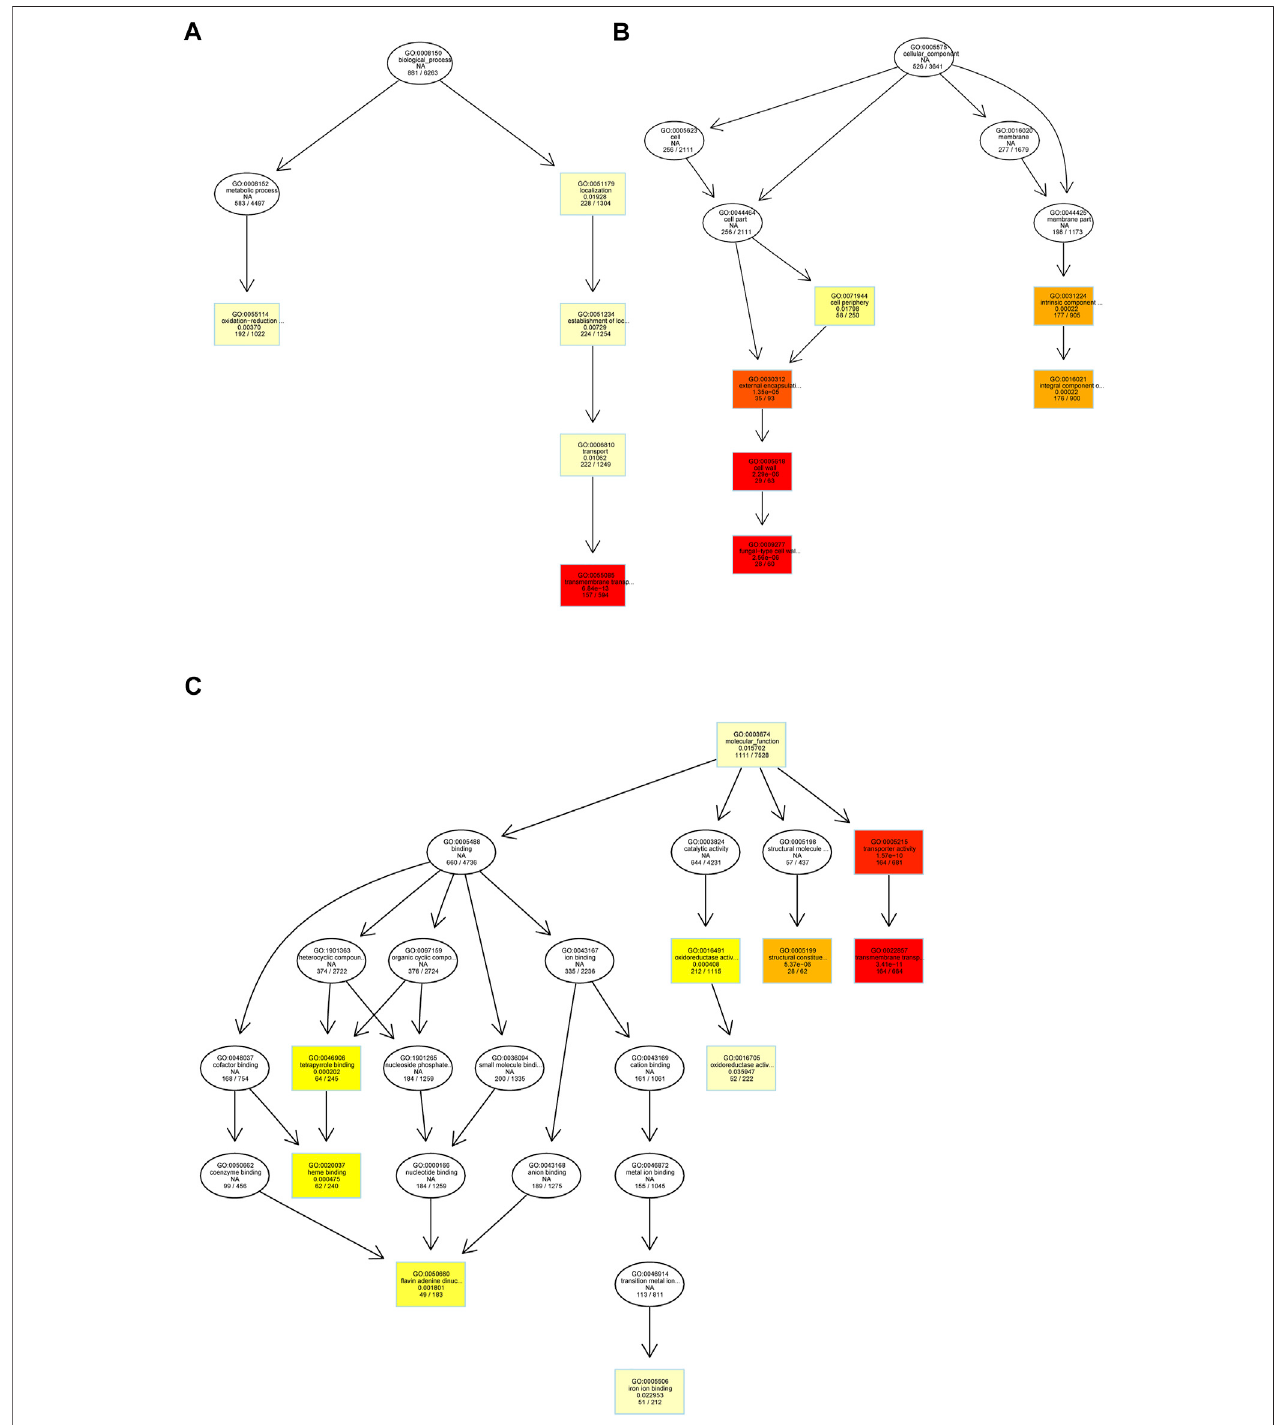
FIGURE 3 | Directed acyclic graph of the top GO terms in Sra1 vs. Sra2 PCG. (A) Biological process; (B) cell component; and (C) molecular function. Each node represents a GO term, and the contents displayed on each node from top to bottom are as follows: GO term ID, description, p value after correction, and the number of DEGs under the GO term. The depth of color represents the degree of enrichment, and the darker the color, the more signi fi cant the degree of enrichment.